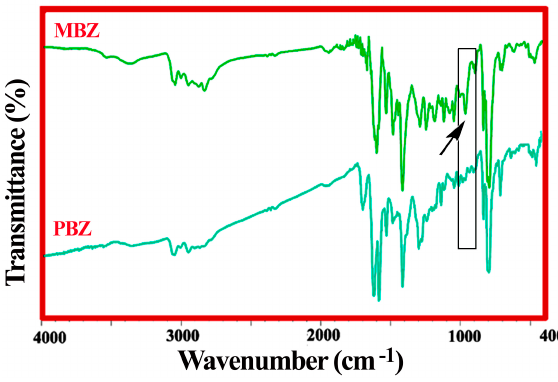
Figure 1. FT-IR spectrum of MBZ monomer and PBZ polymer.